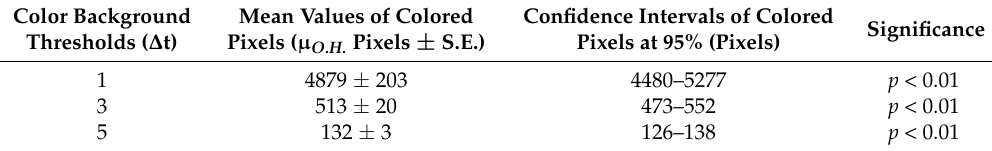
Table 1. Results of the Student’s t -Test procedure that was carried out for each color background threshold under study. Value of means, standard error (S.E.) and confidence intervals that were obtained are reported.